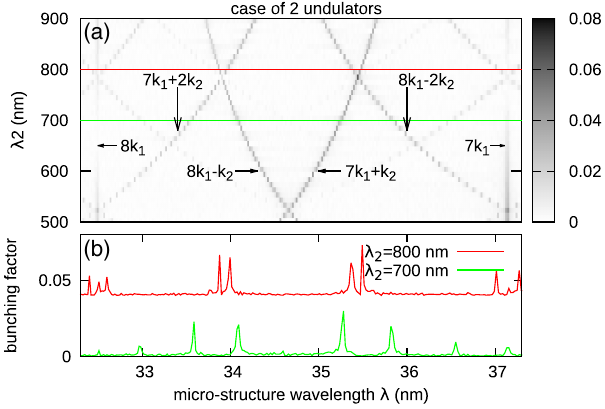
FIG. 3. (a) Bunching factor bf ð λ Þ versus λ 2 in the case of 2 undulators, with λ m 1 ¼ 267 nm, λ m 2 ¼ λ 2 , and R 56 ¼ 8 . 35 × 10 − 5 m. (b) Detail for (red) λ ¼ 800 nm and (green) 2 λ ¼ 700 nm (for figure clarity, the red line is vertically shifted 2 by 0.04). Same other parameters that in Fig. 2 except E ¼ 1 . 5 GV = m, E ¼ 0 . 25 GV = m, N ¼ N λ ¼ λ 1 2 2 1 , ω 2 ω 1 , N ¼ 40 . These parameters permit us to have an energy bin modulation of about A 1 ≃ 5 and A 2 ≃ 1 ( A 2 ¼ 1 . 4 at 800 nm and A 2 ¼ 0 . 82 at 500